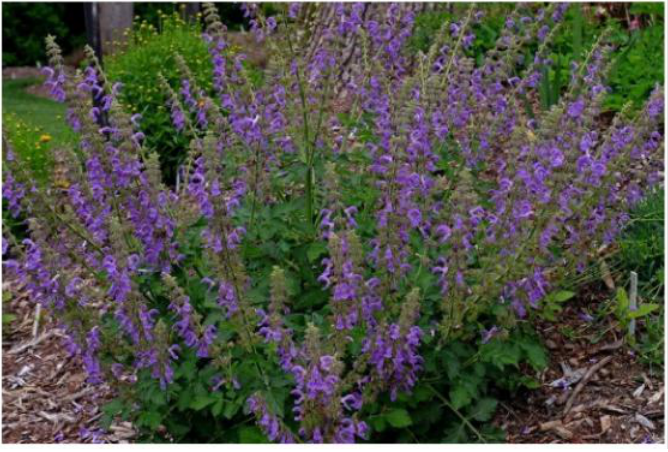
Figure 11. Salvia miltiorrhiza L.